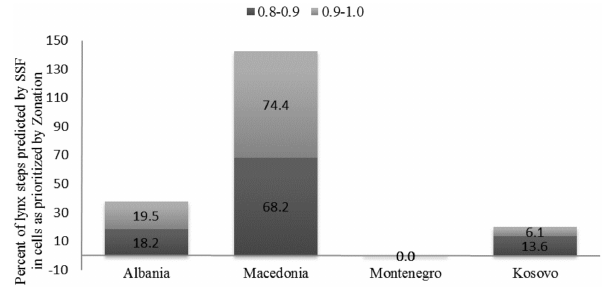
Figure 4. The number of predicted steps by the SSF model for the lynx in the top 10 and 20% of the Zonation solution constrained to the current protected areas aggregated for each